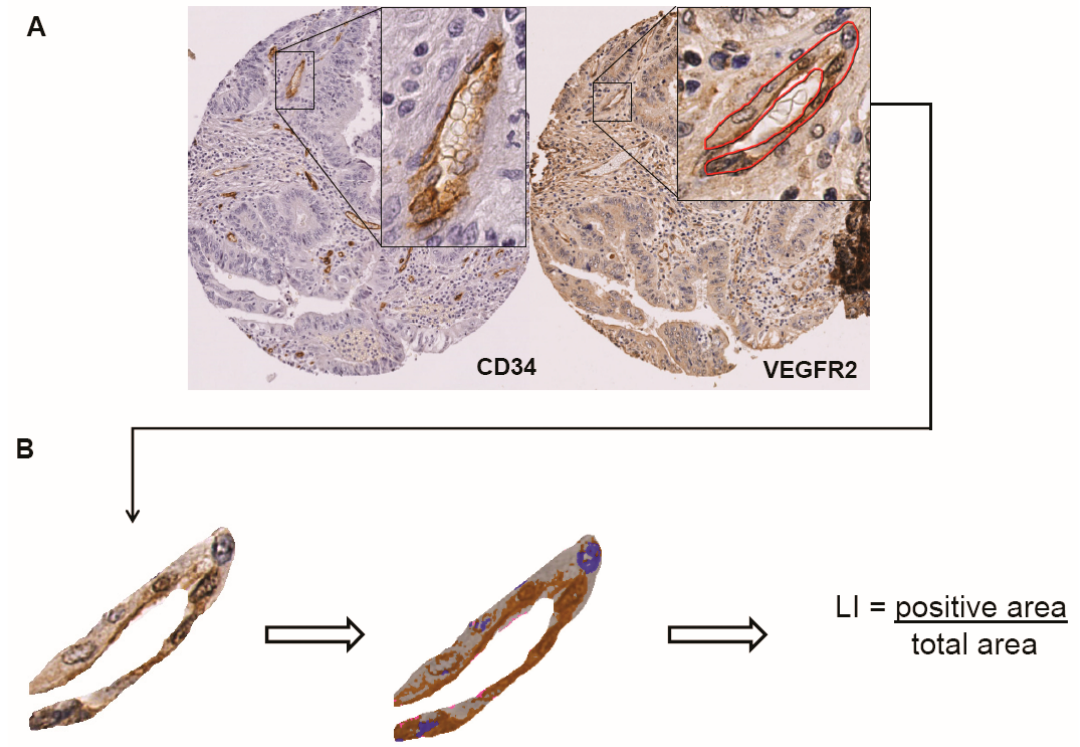
Figure 1. Quantitative image analysis on Tissue MicroArray (TMA): ( A ) After digitization of the TMA slides with a NanoZoomer Digital Slide Scanner (Hamamatsu, Hamamatsu City, Japan), blood vessels, highlighted by anti-CD34 immunostaining, were manually marked on the digital vascular endothelial growth factor receptor (VEGFR) slides by a pathologist using the NDP.view software. The tissue core diameter is 600 µ m. ( B ) The delineated regions were imported into the Visiopharm software to quantify the VEGF, VEGFR-1 or VEGFR-2 expression levels using the labelling index (LI), i.e., the percentage of the immunoreactive area within the vessel area.